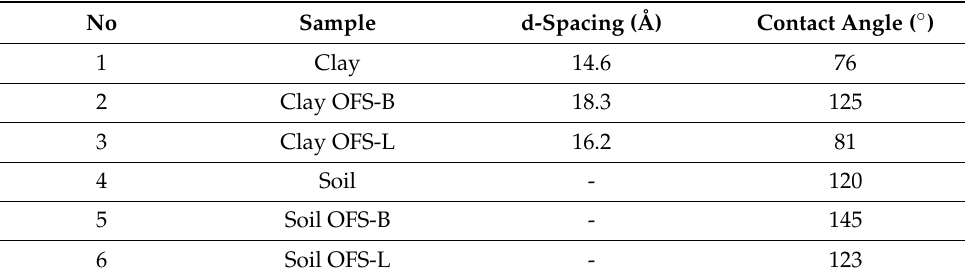
Table 2. d-spacing and contact angle of silane modified/unmodified clay and soil